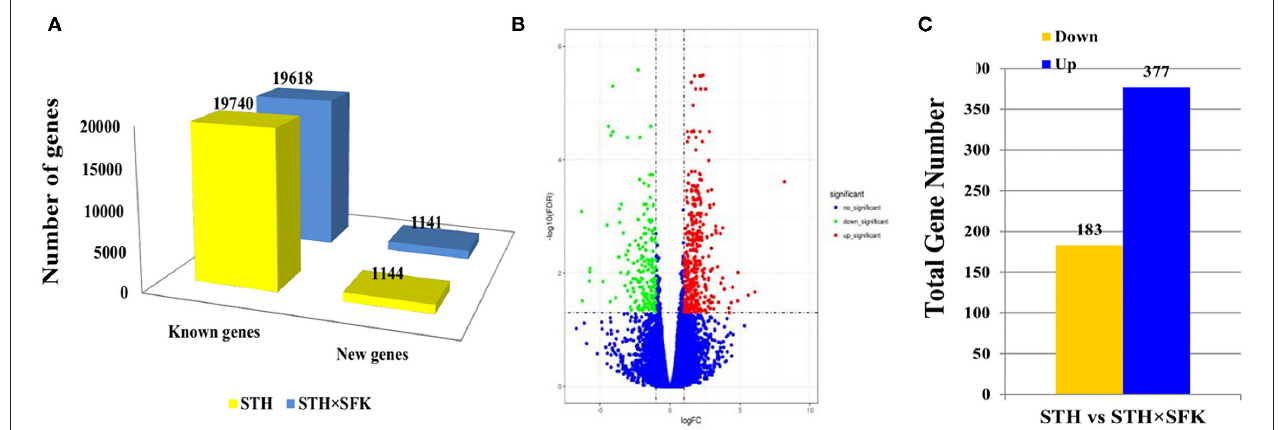
FIGURE 3 | Transcriptome data analysis of longissimus dorsi muscle tissue of STH and STH × SFK sheep populations. (A) The total number of genes sequenced by the transcriptome in the two sheep groups. (B) DEG’s volcano map. (C) Identify the DEGs of two sheep.